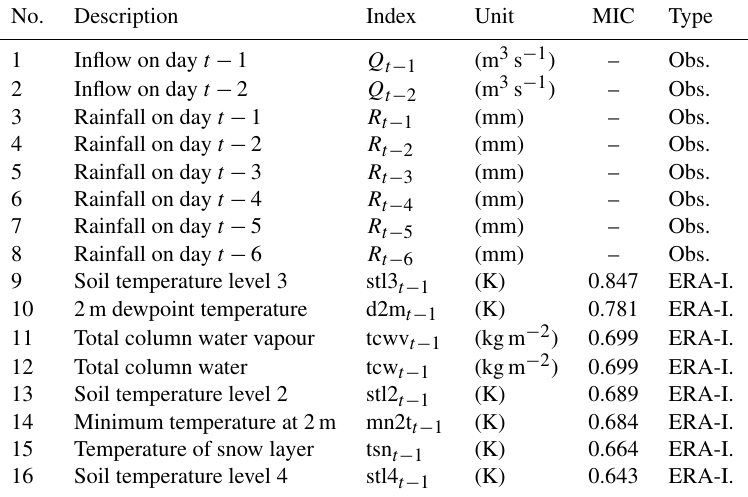
Table 3. List of input data for GBRT-MIC. There are of two input types, observed and reanalysis variables. The reanalysis variables are available twice a day at 00:00 and 12:00UTC. The cumulative variables (e.g. total column water) are the sum of two periods, and the instantaneous variables (e.g. 2m dewpoint temperature) are the mean of two